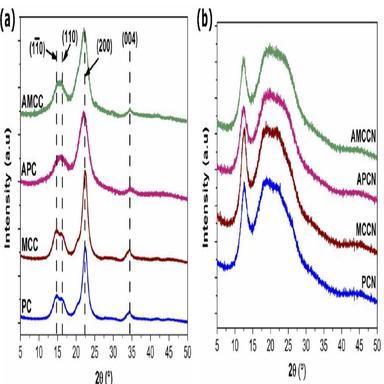
X-ray diffractograms of (a) functionalized samples and their starting precursors; (b) nitrated samples.